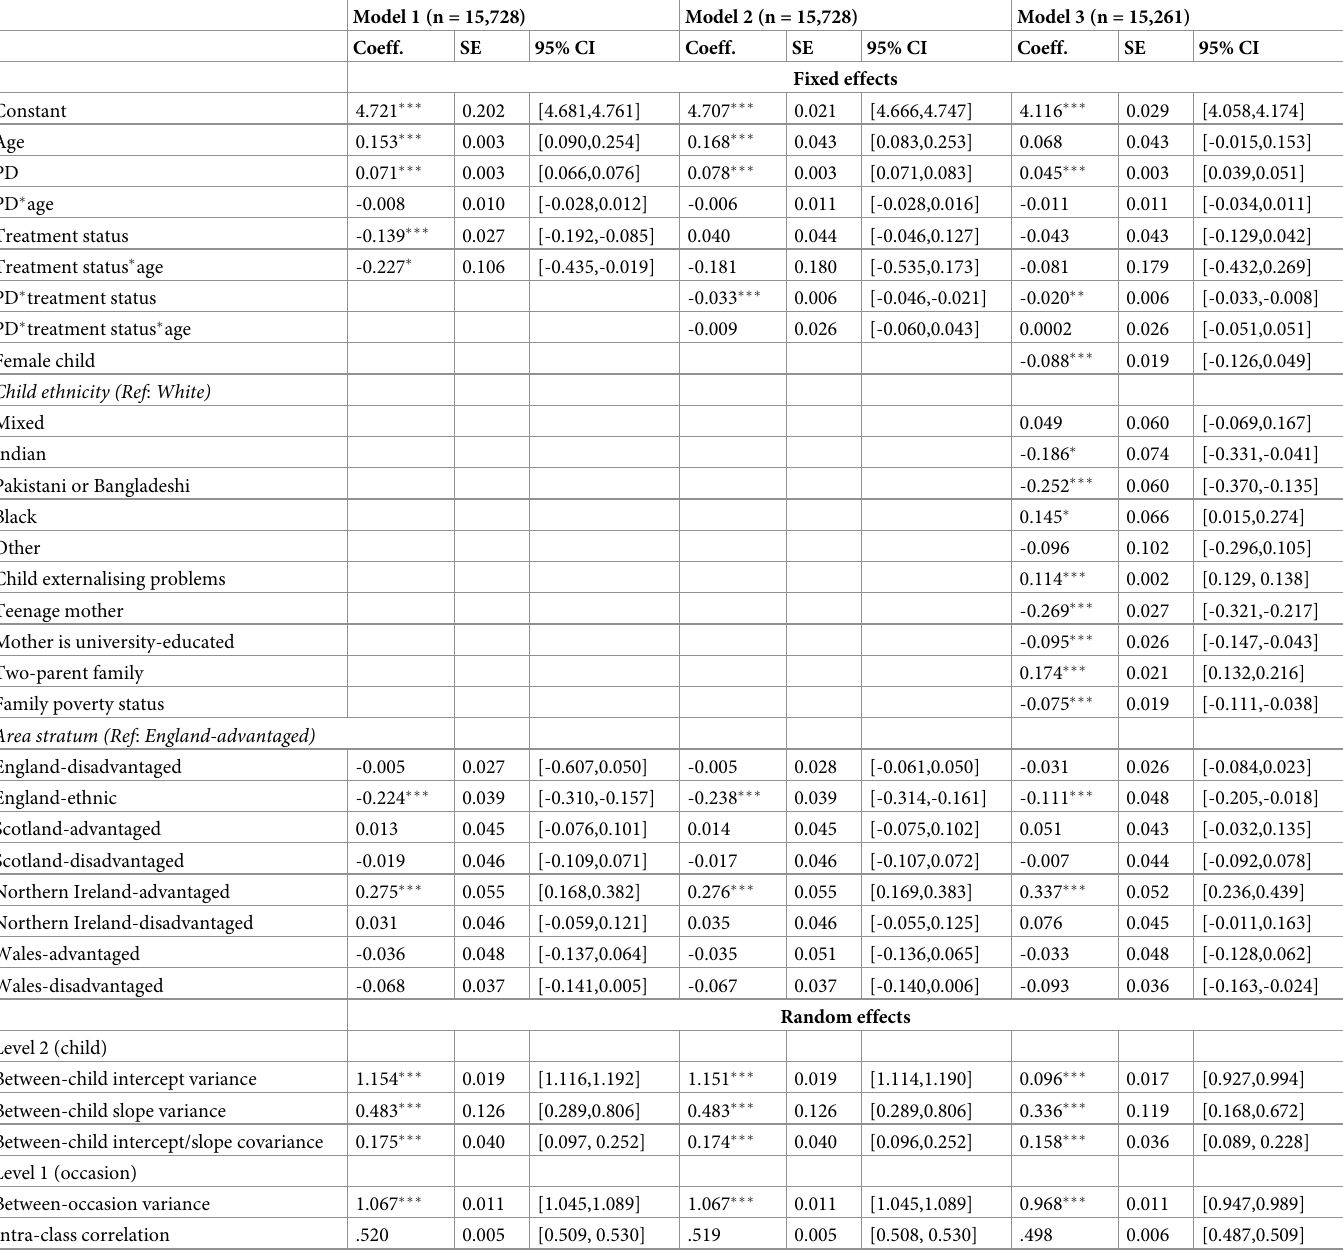
Table 4. Fixed effects estimates and variance covariance estimates for Models 1–3 predicting harsh